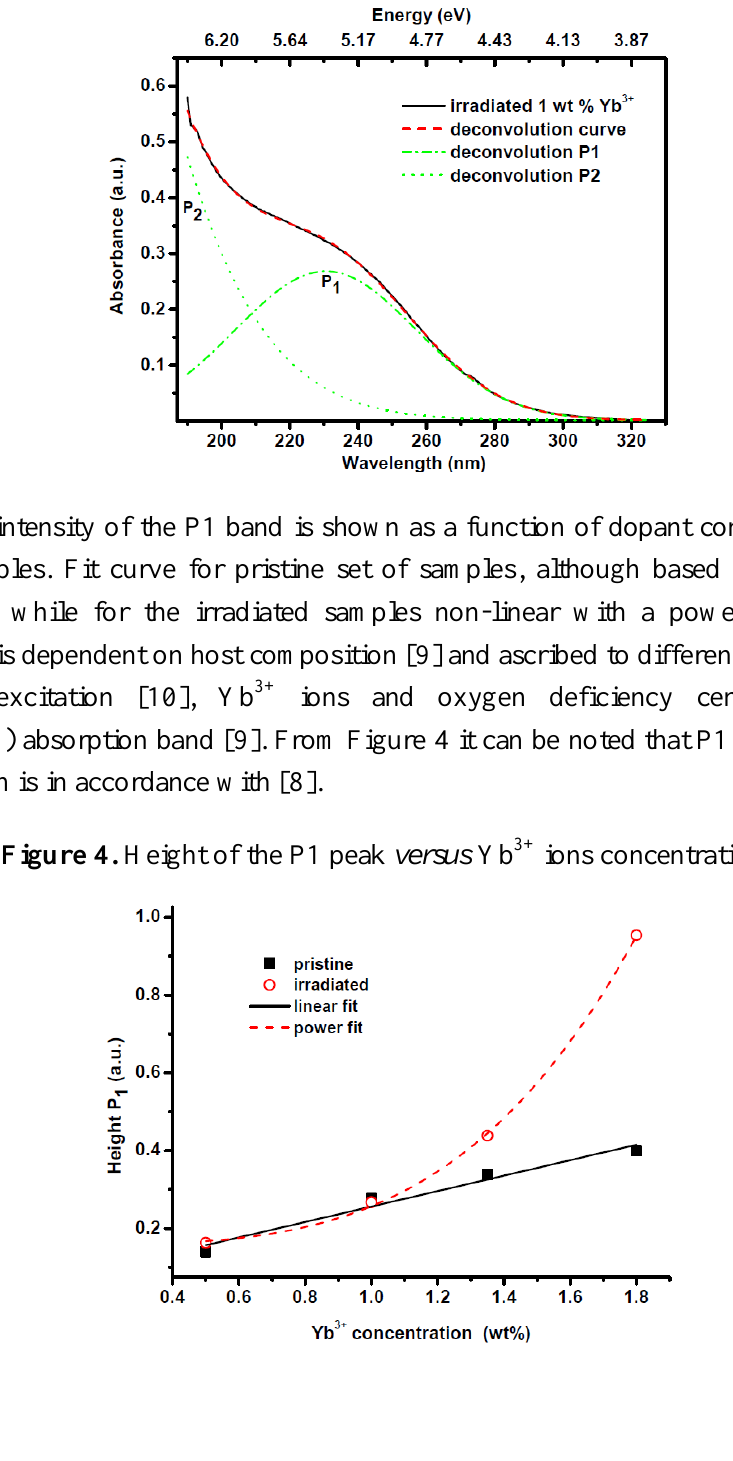
Figure 3. Gauss curve deconvolution of UV band for 1 wt% Yb-doped preform core.